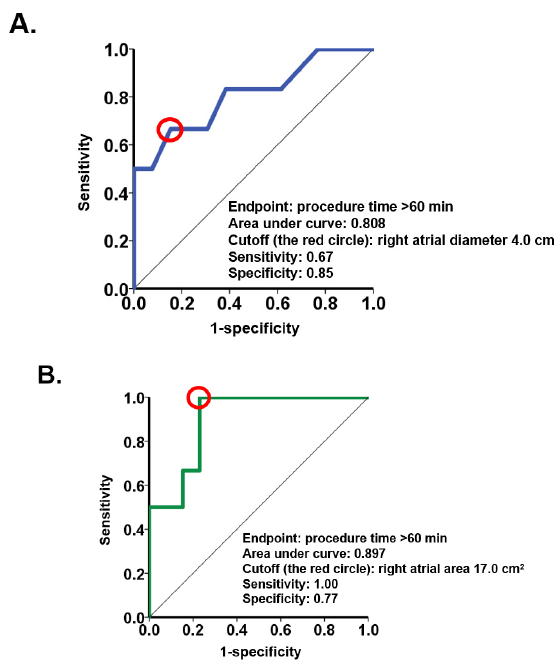
Figure 1. Receiver-operating characteristic curve for predicting procedure time >60 min. ( A ) Re- ceiver-operating characteristic curve of right atrial diameter. ( B ) Receiver-operating characteristic curve of right atrial area.